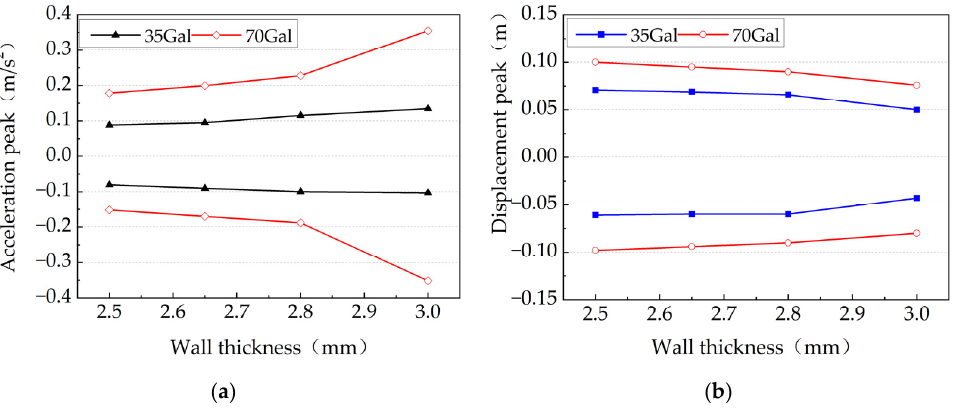
Figure 28. Dynamic response of structure under the Nihonkai-Chubu earthquake: ( a ) Comparison of acceleration peak; ( b ) Comparison of displacement peak.